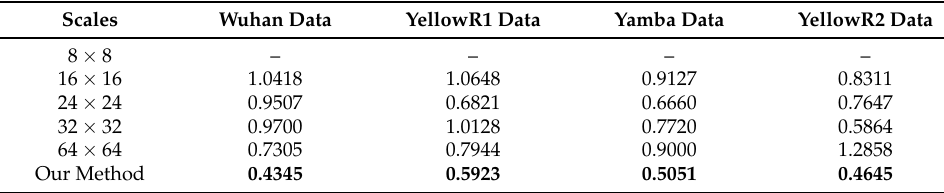
Table 5. Registration results (RMSE) of image blocks of different